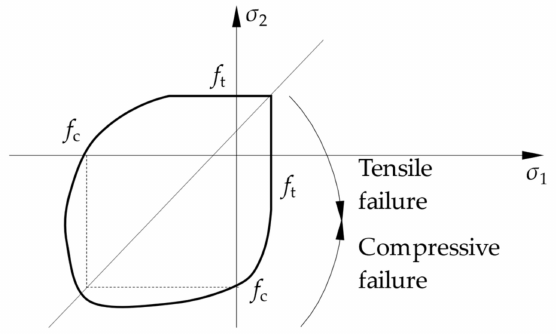
Figure 6. The standardized biaxial failure